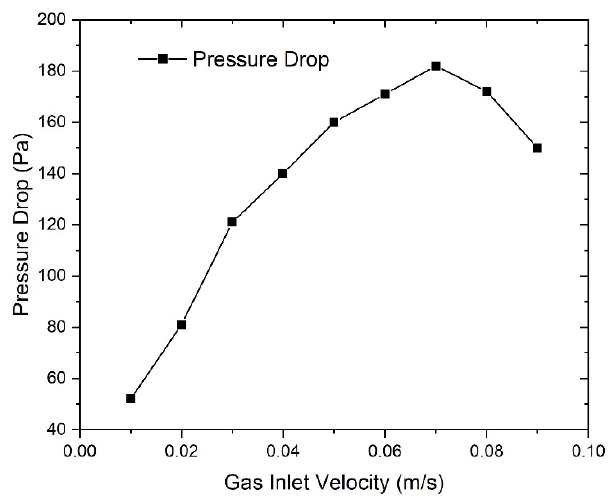
Figure 7. ( a ) Variation of gas and liquid column length with gas velocity conditions; ( b ) Variation of the average liquid column flow velocity with gas velocity conditions.